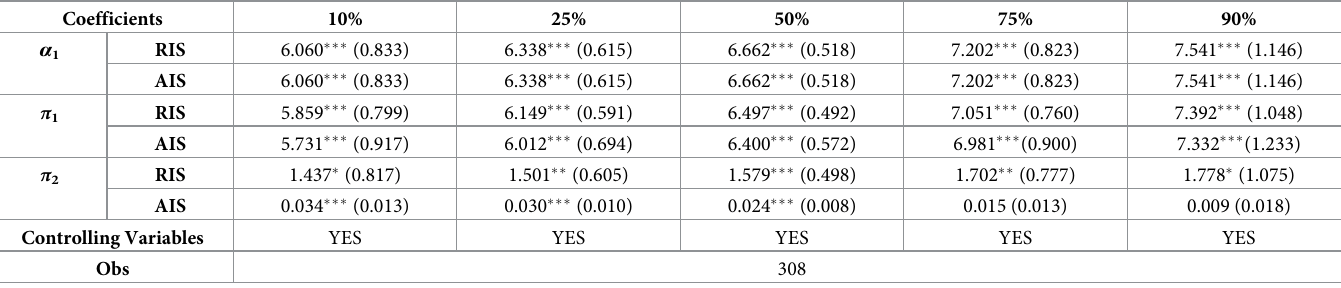
Table 10. Regression results of mechanism